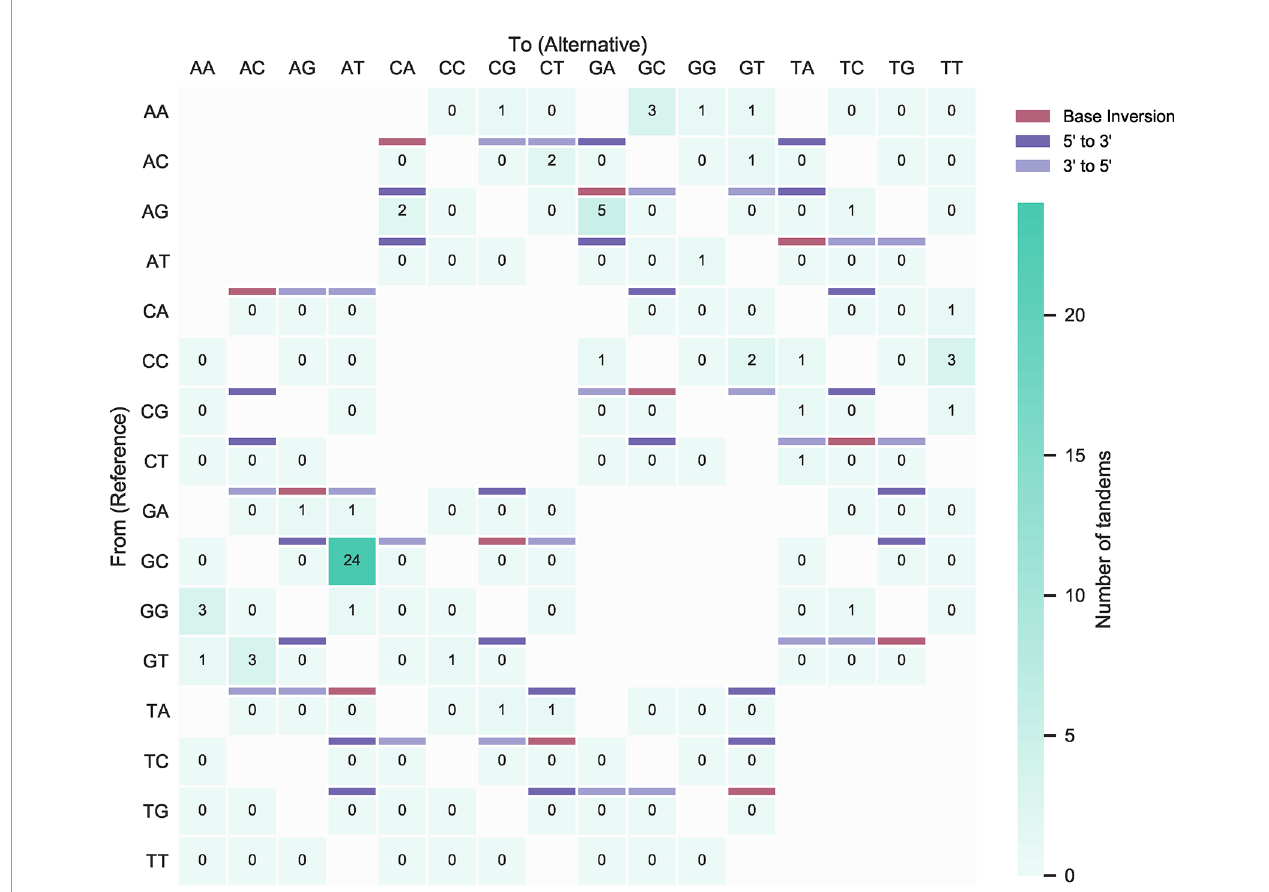
FIGURE 7 | Incidence of tandem dinucleotide substitutions in UNG de fi ciency. All dinucleotide substitutions from unique IGHV sequences obtained from an UNG de fi cient patient. Burgundy cells represent sequence inversions, light and dark purple cells represent juxtalocations of the 5 ’ and 3 ’ base in the pair (as seen from the non-transcribed strand), respectively. For unshaded cells, juxtalocation could not be assessed due to one or more nucleotides in the reference sequence matching the mutated sequence. Results could not be reliably corrected for dinucleotide substitutions that did not occur in tandem for each mutation independently due to the size of the dataset. However, simulation of dinucleotide substitutions resulting from independent single nucleotide substitutions showed an almost identical number of dinucleotide substitutions (n=76) as the number that was observed (n=67), suggesting that this UNG de fi cient patient has no tandem substitution